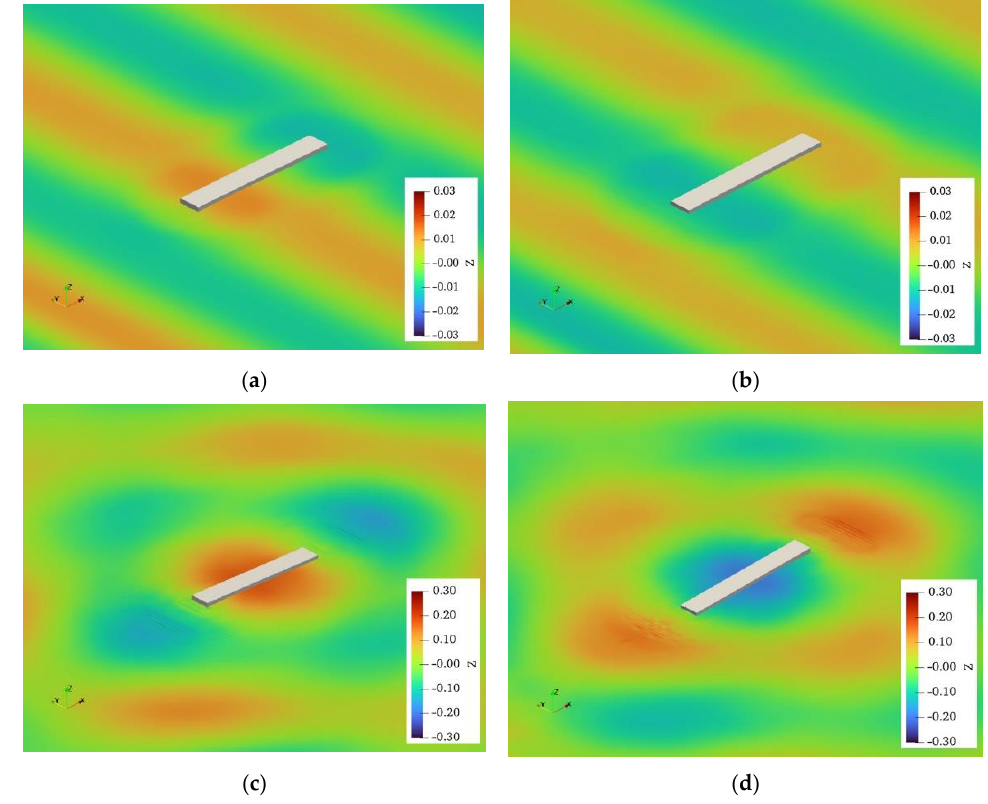
Figure 20. Floating body and free-surface evolution: ( a ) maximum pitch angle in regular waves; ( b ) minimum pitch angle in regular waves; ( c ) maximum pitch angle in rogue waves; ( d ) minimum pitch angle in rogue waves.